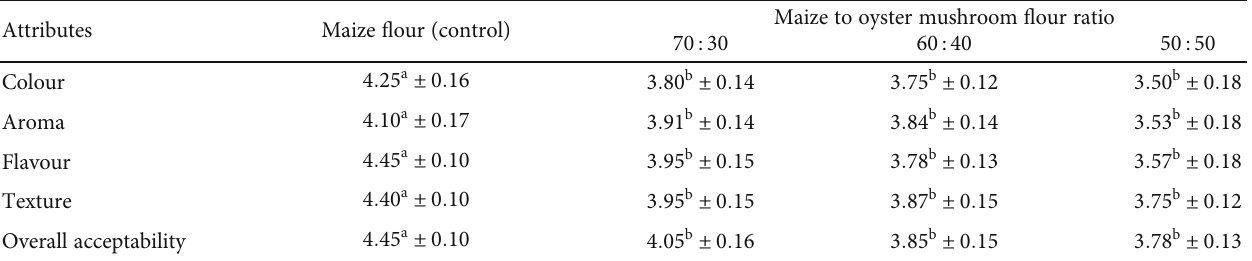
Means in the same row with di ff erent letters as superscript are signi fi cantly di ff erent ( p < 0 : 05